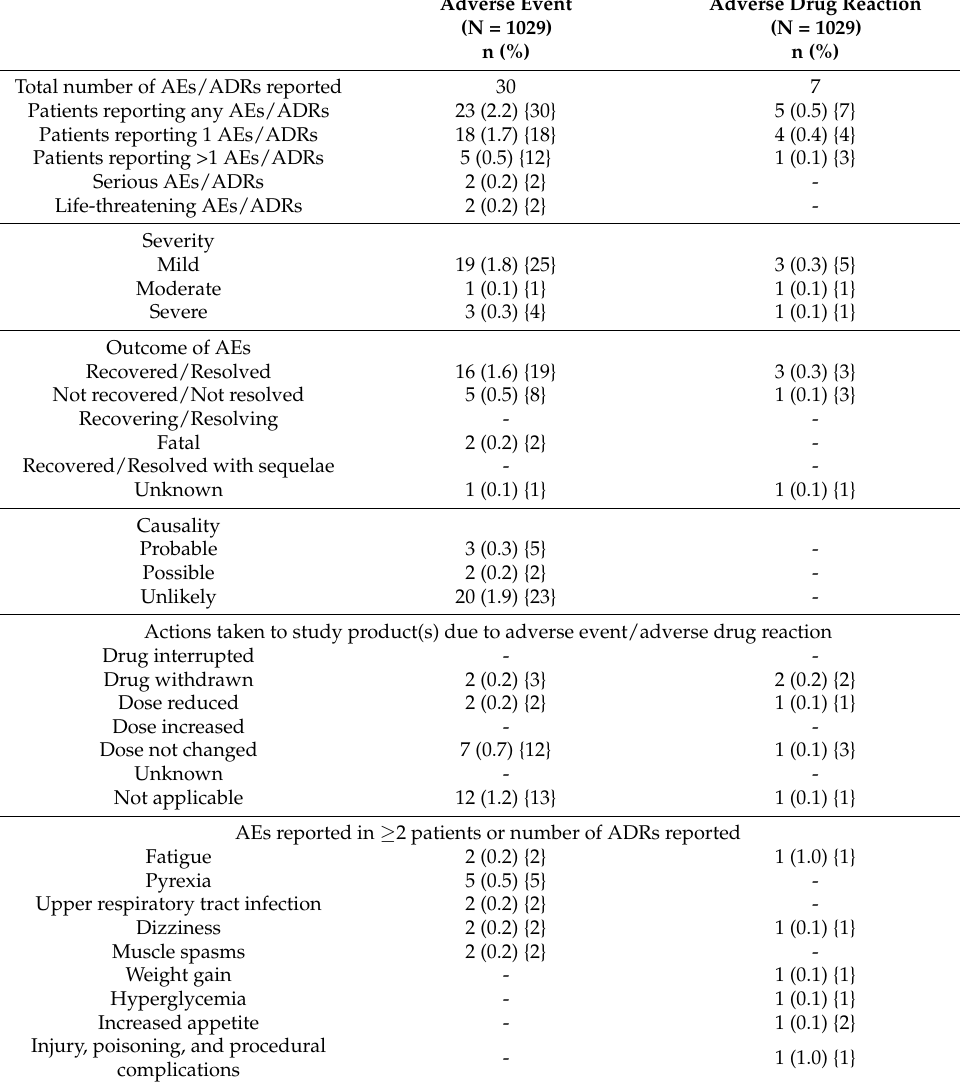
Table 3. Summary of adverse events and adverse drug reaction (safety analysis